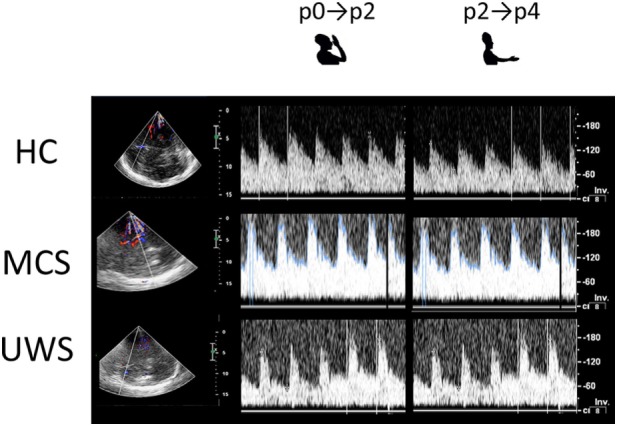
Shows the transcranial Doppler waveforms (on the right) with color Doppler (on the left) from left middle cerebral artery during motor imagery across the two hand positions (p) explored in a representative subject for each group [HC, minimally conscious state (MCS), and unresponsive wakefulness syndrome (UWS)]. Both insonation depth (left vertical bar) and flow velocity (cm/s, right vertical bar) are provided.